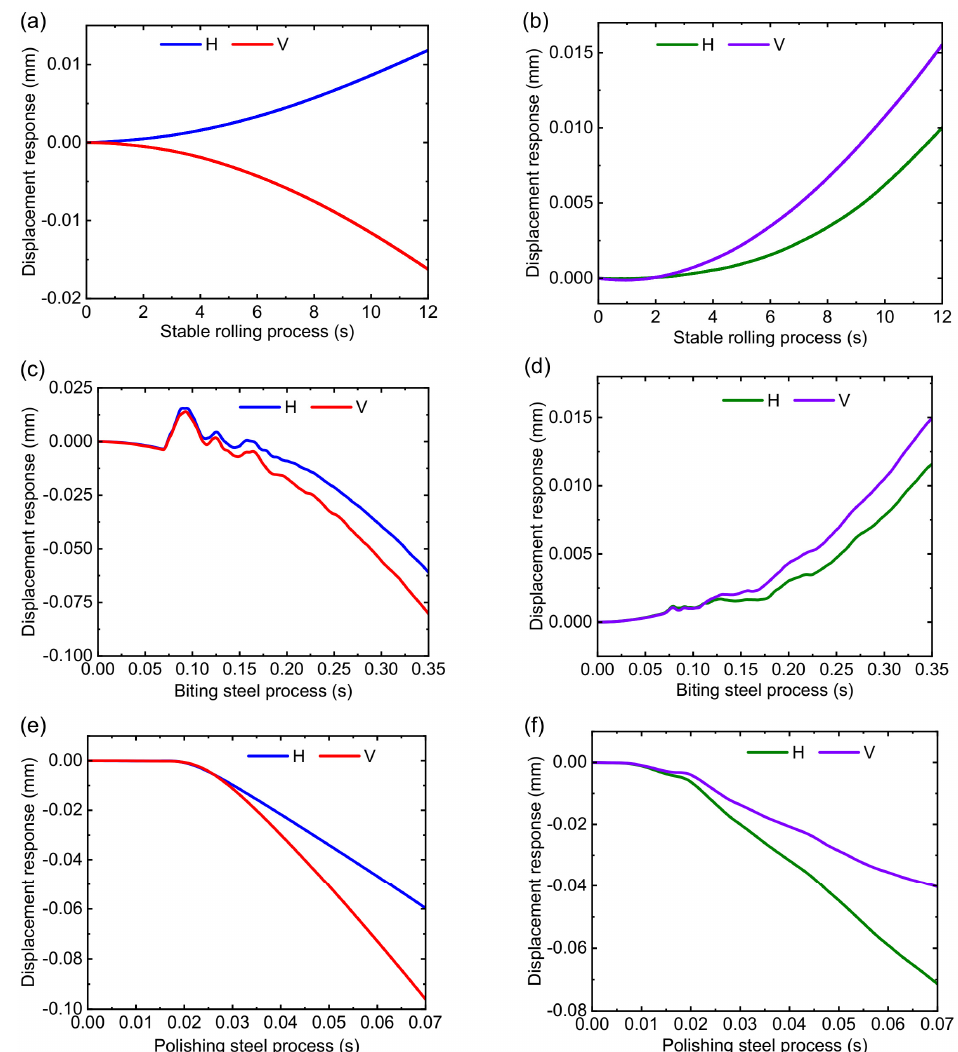
Figure 15. Transient displacement response of the system when the finished weathering steel thick- ness is 1.6 and 3.2 mm: ( a ) stable rolling process of the 1.6 mm, ( b ) stable rolling process of the 3.2 mm, ( c ) biting steel process of the 1.6 mm, ( d ) biting steel process of the 3.2 mm, ( e ) polishing steel process of the 1.6 mm, and ( f ) polishing steel process of the 3.2 mm.